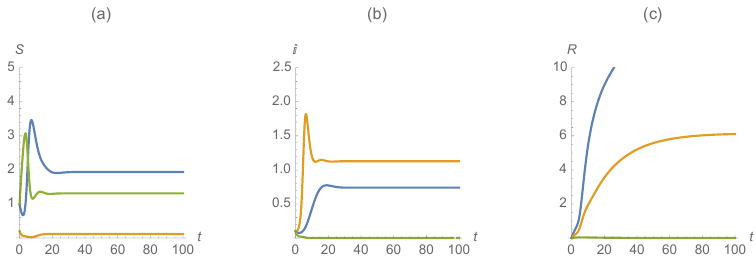
Figure 6. ( a ) S j , ( b ) I j , and ( c ) R j . The first disease is represented in blue, the second in orange and those susceptible/infected/recovered by diseases in green.